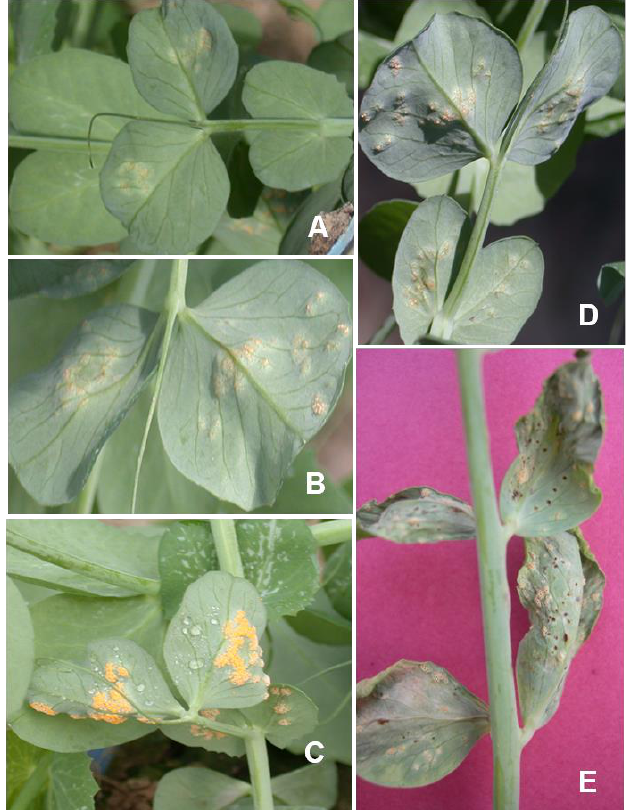
Figure 2. ( A ) Symptoms development of U. viciae-fabae on pea after infection ( B ) Aecia development after inoculation by Uredia ( C ) Acedial pustules on the abaxial side of the leaf ( D ) Small uredial pustules ( E ) Acedial and Uredial pustules.